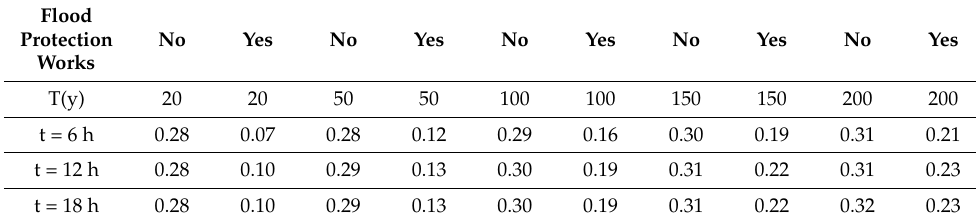
Figure 12. Calculated building vulnerability grouped in 5 classes. Table 8. Average value of risk on Koropouli